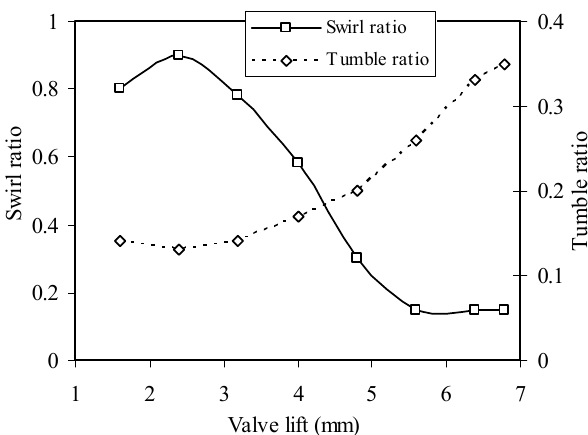
Figure 1. Influence of reduced maximum valve lifts (MVL) on the swirl ratio and tumble ratio under steady flow measurement.